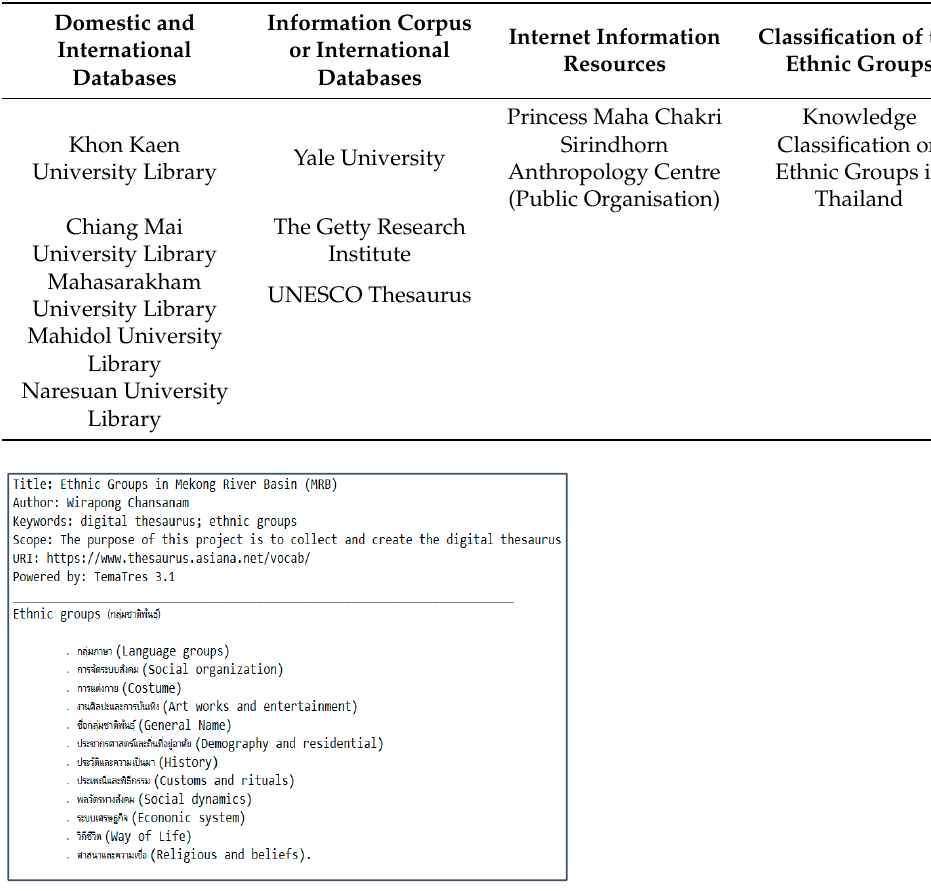
Table 1. The information corpuses of international databases.